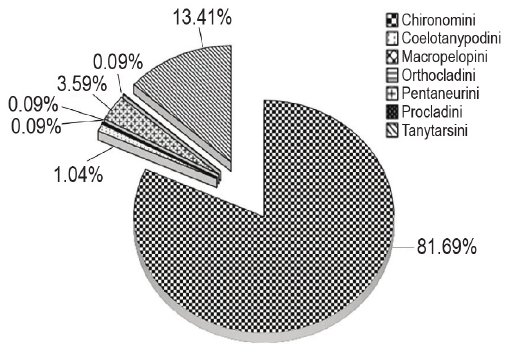
Figure 5. Chironomidae tribes in Lake Figueira found in all